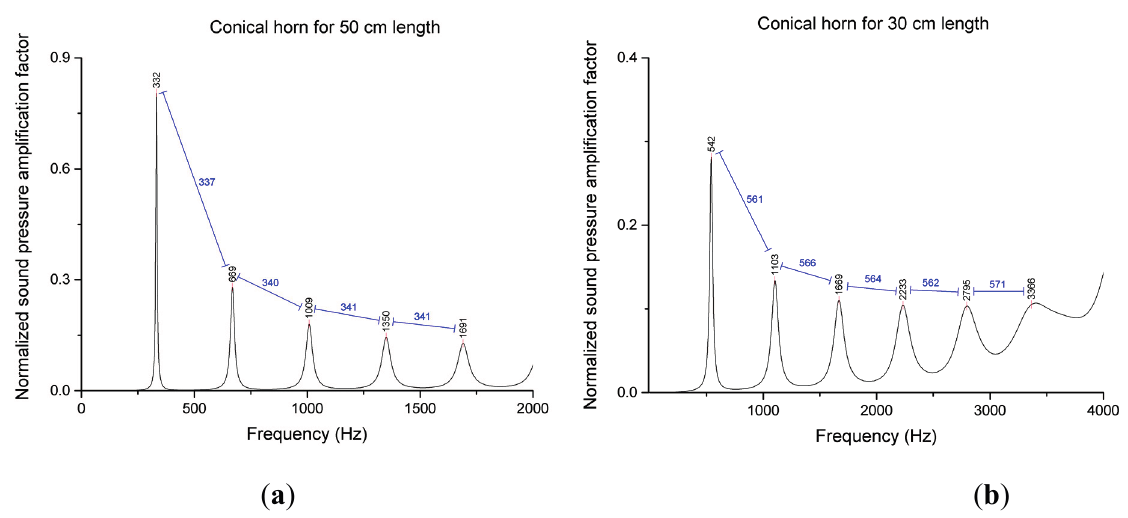
Figure 6. Normalized sound pressure amplification factor for conical horn with ( a ) 50 cm radial length; and ( b ) 30 cm radial length.